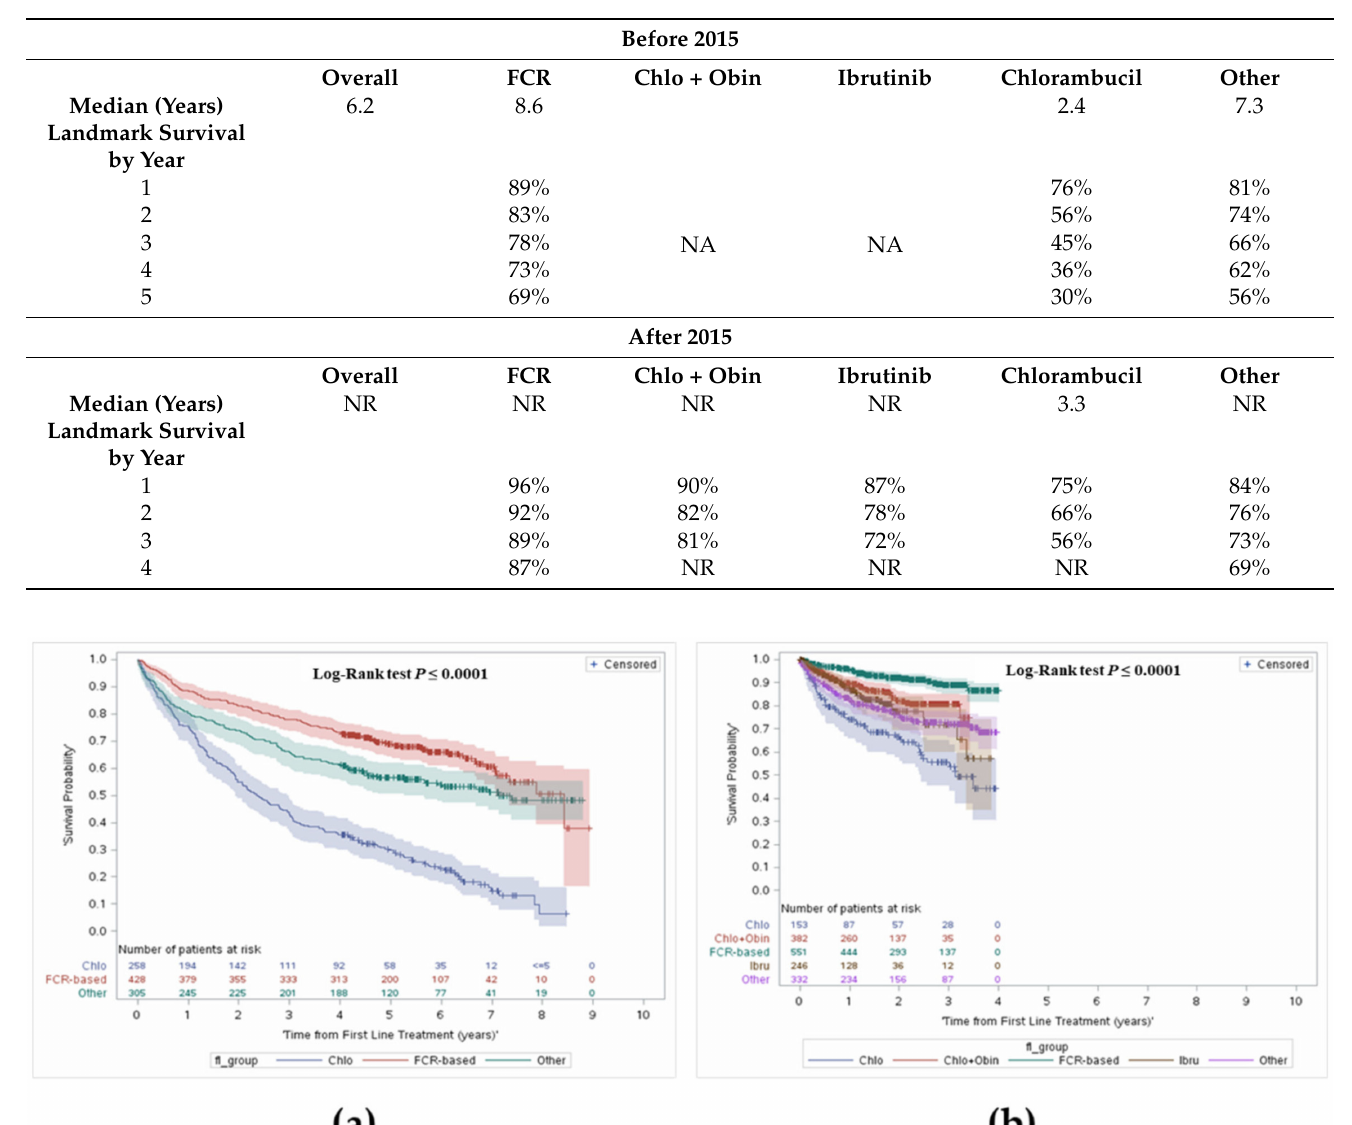
Table 2. Survival rates stratified by type of treatment received in first line before and after 2015.